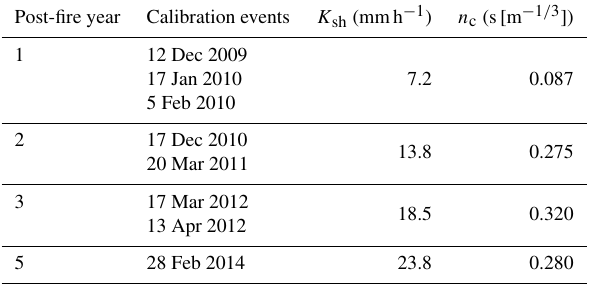
Table 1. Summary of model parameters for post-fire years 1, 2, 3, and 5. The saturated hydraulic conductivity on hillslopes ( K sh ) and hydraulic roughness in channels ( n c ) are the average of values cali- brated in post-fire years 1, 2, 3, and 5 (Liu et al.,